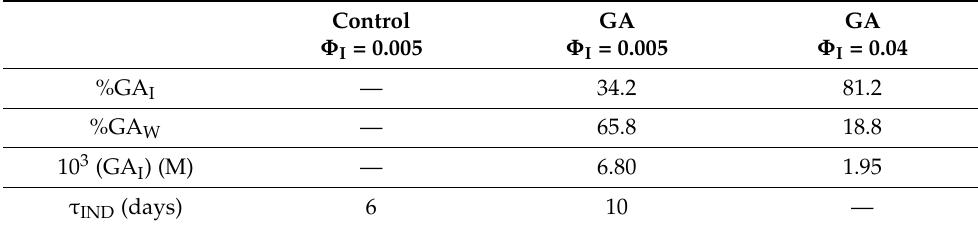
Table 2. Percentages of GA in the interfacial and aqueous regions of O/W nanoemulsion determined in the intact emulsions by employing the kinetic method [10] at the two limiting emulsifier volume fractions ( Φ I ). The values of the induction times ( τ IND ) in the absence and presence of GA are also